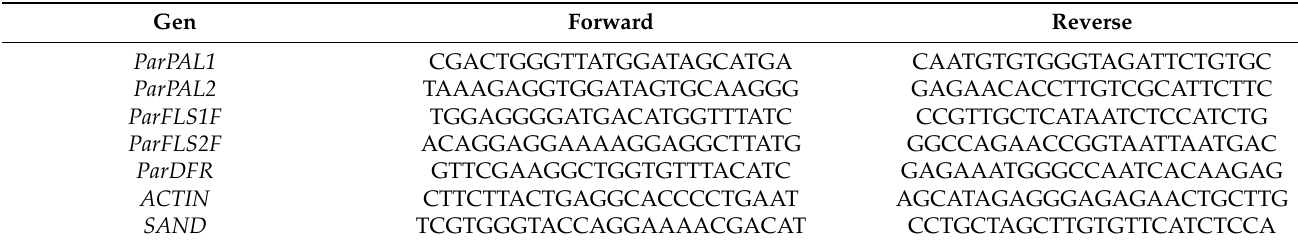
Table 6. Genes and